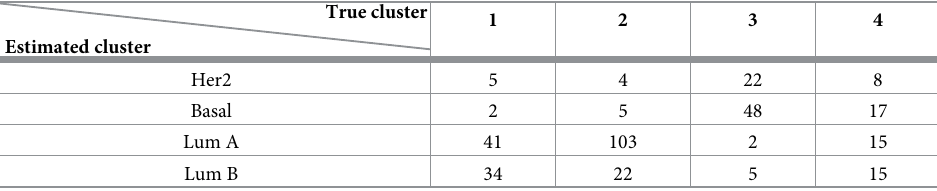
Table 1. Confusion matrix for the clustering assignment. Estimated cluster